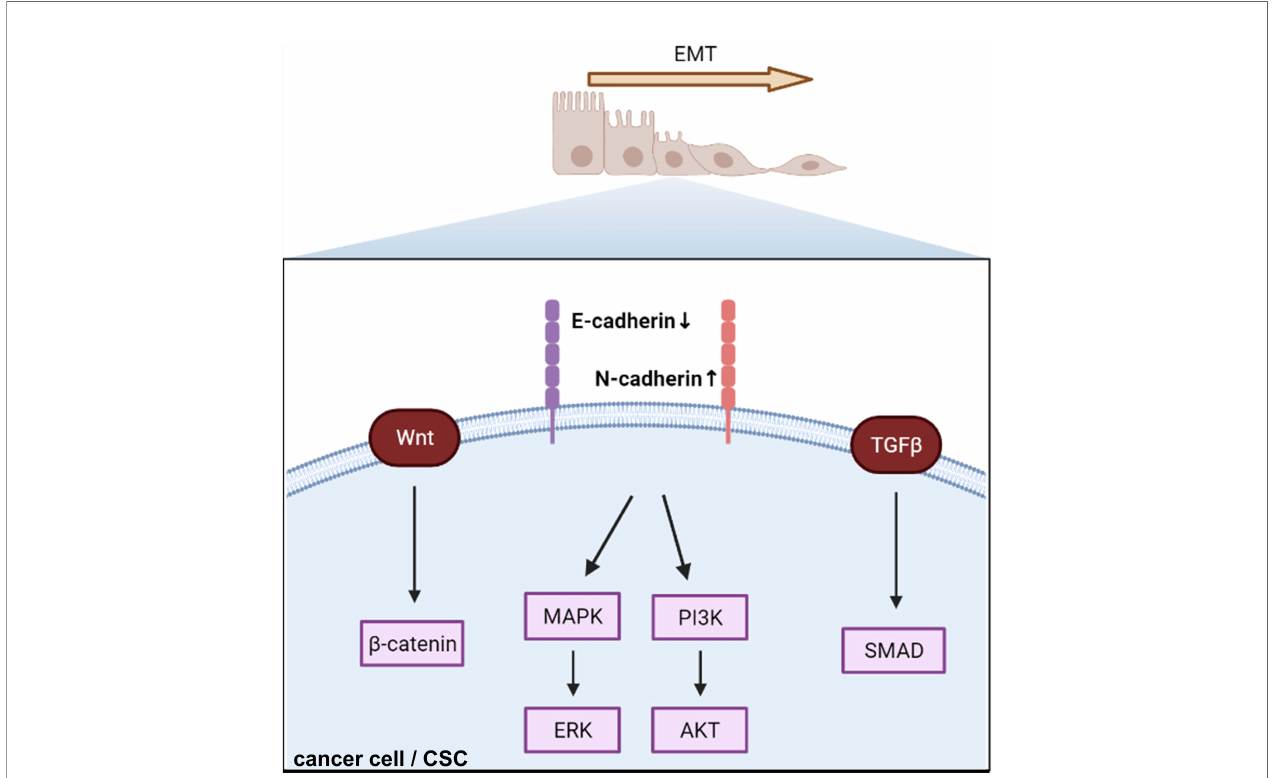
FIGURE 3 | Cadherin regulates epithelial – mesenchymal transition and triggers intracellular signaling. EMT, epithelial – mesenchymal transition; CSC, cancer stem